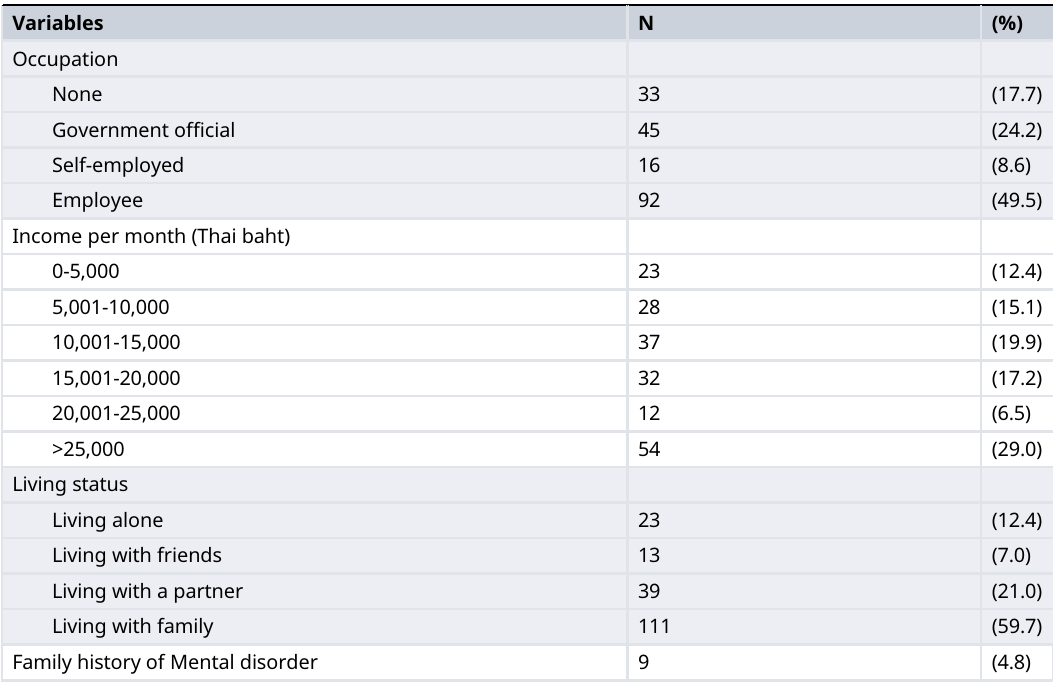
Table 2 demonstrates the clinical characteristics of the patients. Approximately 16% of participants had at least one underlying medical illness. Only 1.1% of participants had an underlying mental disorder. In addition, around 80% of participants had mild COVID-19 symptoms, and the symptoms lasted at least 7 days. The median duration of hospitel admission was 12 days (IQR 10-13). Most participants were admitted alone (86.6%), and eventually, they could be discharged from the hospitel after 7 days of admission. Interestingly, around 90% of participants perceived that they were provided psychological support while in the hospitel.